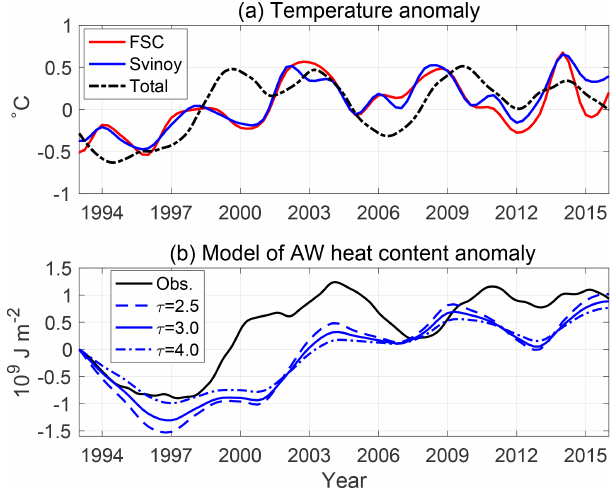
Figure 6. (a) Sea surface EN4 temperature anomaly ( ◦ C) in the Faroe–Shetland Channel (FSC, red) and in the Svinøy section (Svi- noy, blue), used as proxies for the inflow temperature anomaly T (cid:48) i (t) . The dashed black line shows the total model forcing temper- ature needed to reproduce the observed AW heat content anomaly (black line in b ). (b) Modelled AW heat content anomaly (blue), which is obtained by integrating Eq. (15) forward in time, using the Svinøy section temperatures and the e -folding timescales ( τ ) equal to 2.5, 3.0 and 4.0 years. The black line shows the heat content AW anomaly estimated from the EN4 data; the same data are shown in Fig. 4, but here they are low-pass-filtered with a 24-month running